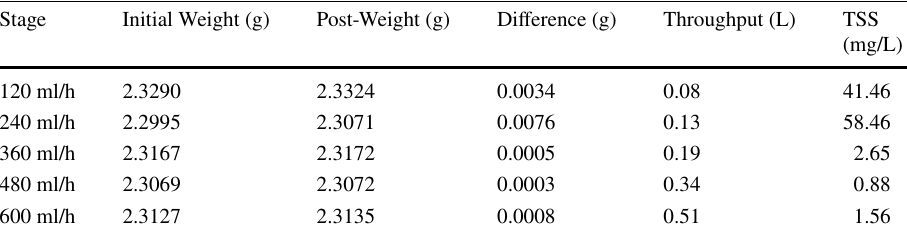
Table 8 TSS measurements for core flood 2